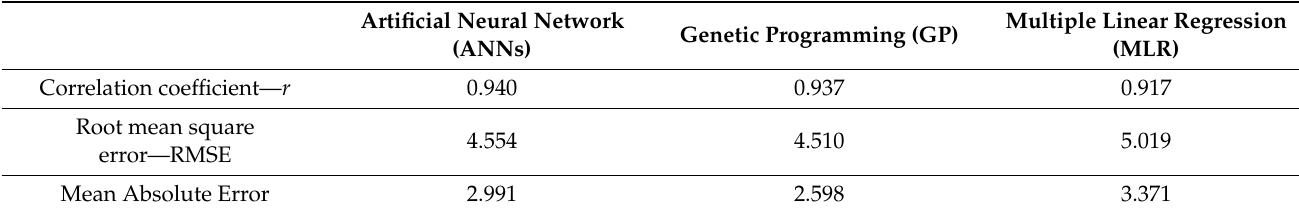
Table 5. Performance of models developed using ANNs, GP and